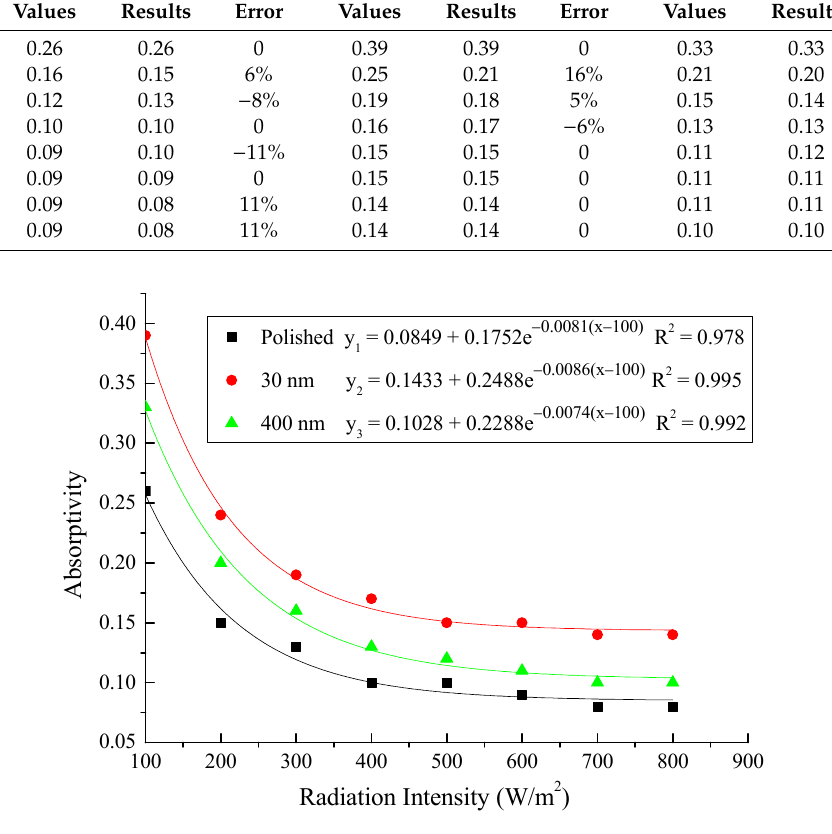
Figure 22. Correlation of the absorptivity with radiation intensity for the three testing rigs.